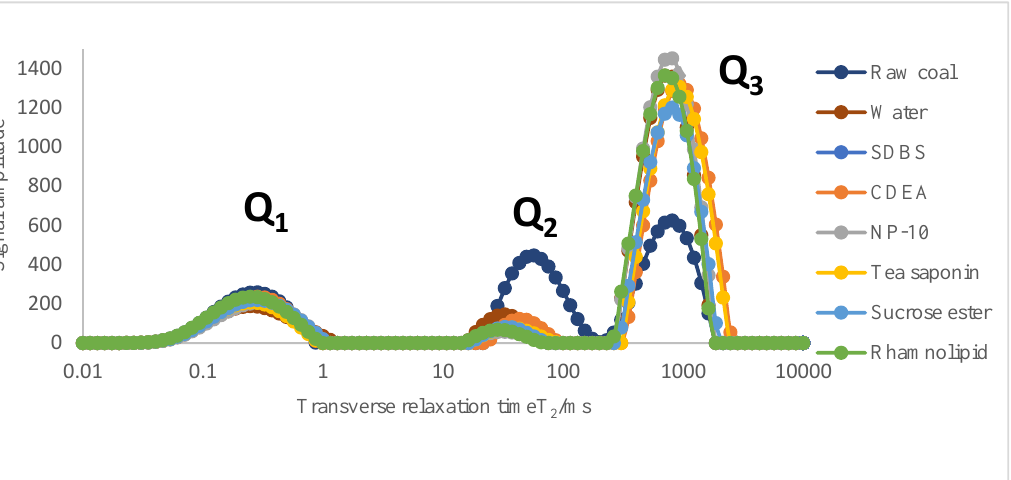
Figure 6. T 2 spectra of coal gas adsorption process modified by different surfactants under 5–6 MPa pressure.